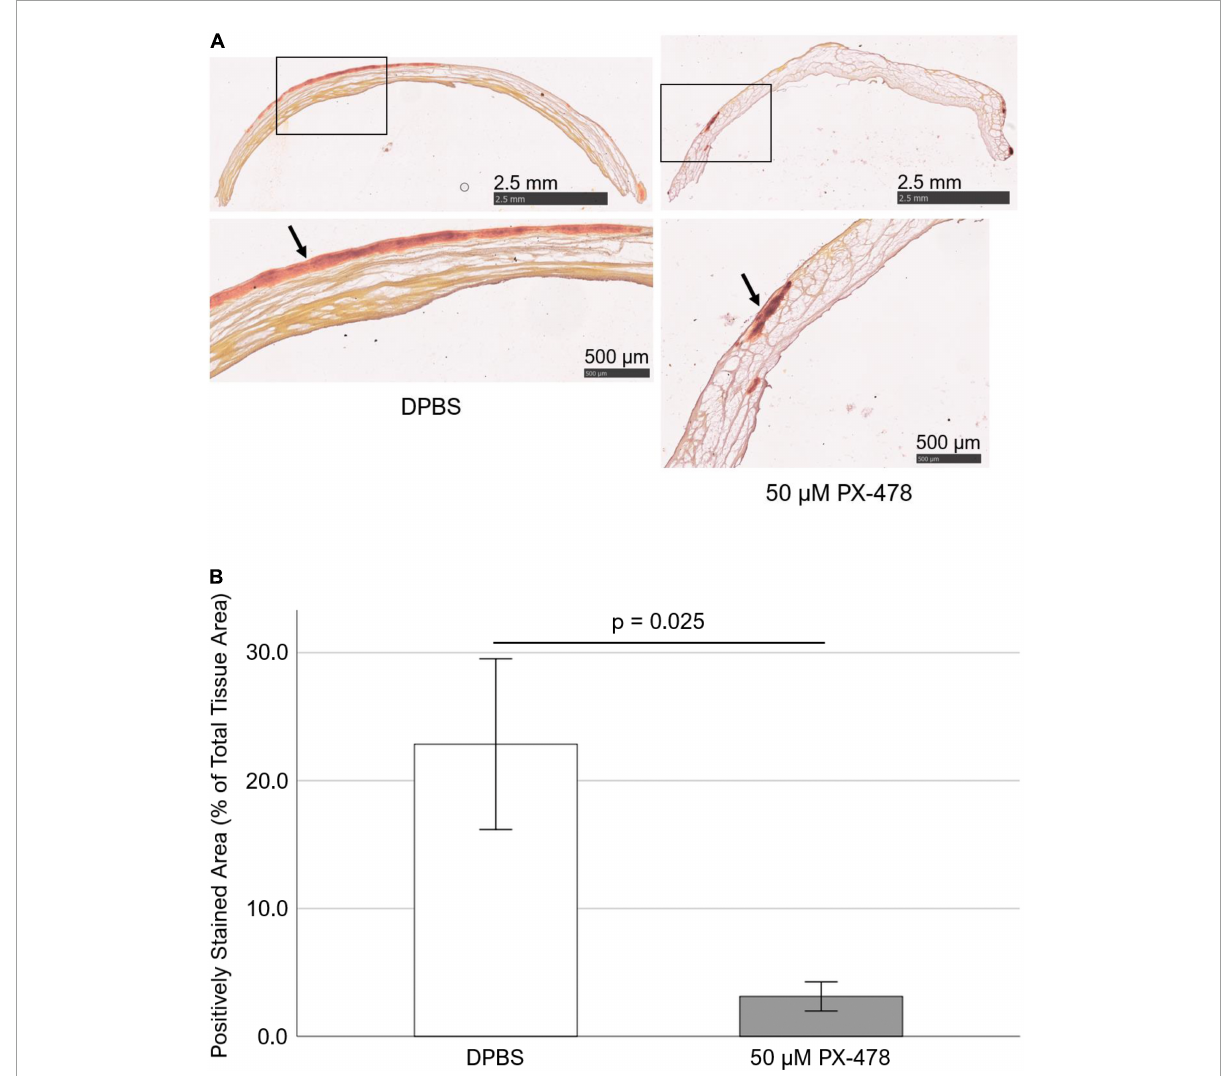
FIGURE3 PX-478 inhibits porcine aortic valve (PAV) calcification in response to cyclic stretching. (A) Representative Alizarin Red staining images of PAV leaflets (top row: lower magnification, bottom row: higher magnification) after 24 days of 15% stretch in osteogenic medium. Arrows indicate areas of calcification. (B) Quantification of Alizarin Red staining images of PAV leaflets after 24 days of 15% stretch in osteogenic medium ( n = 5–7).